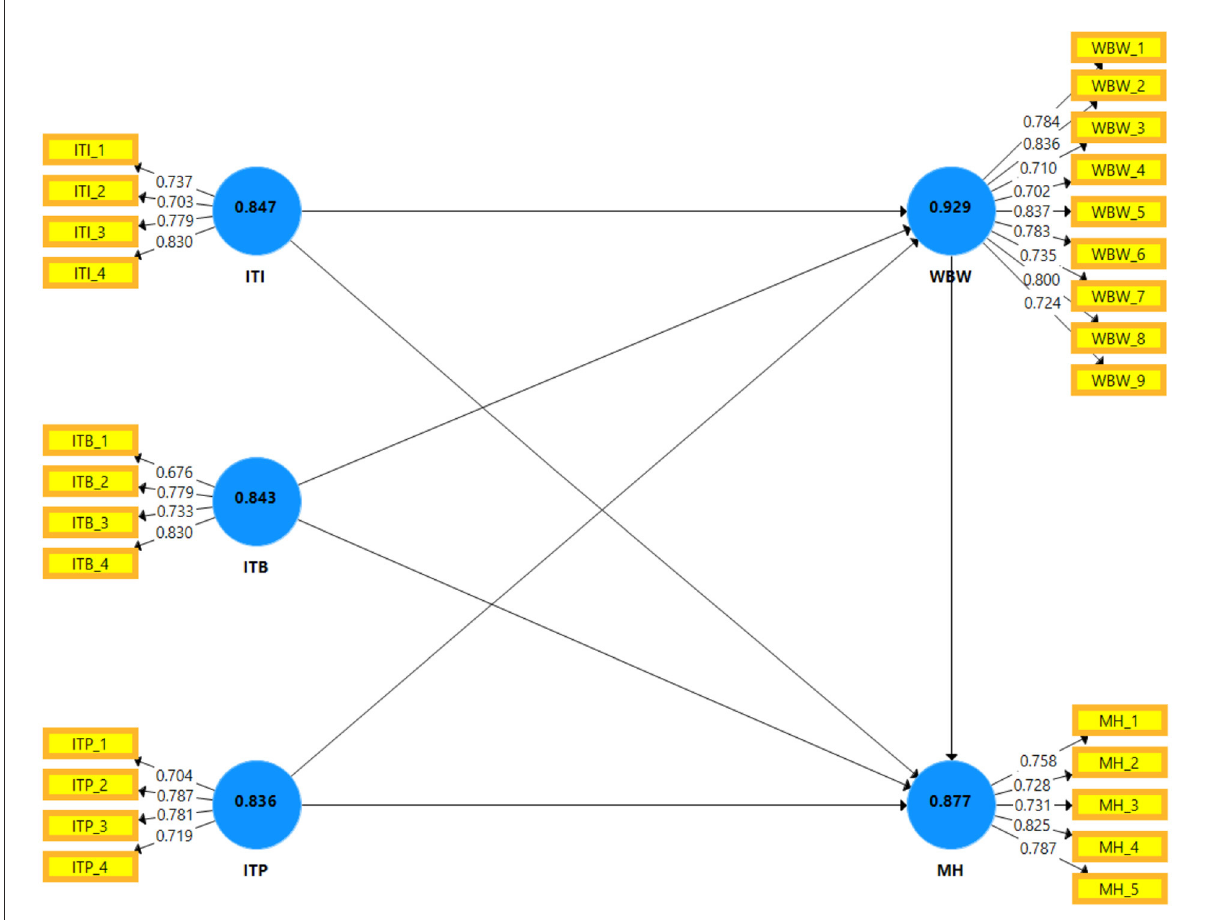
FIGURE2 Measurement model PLS-SEM